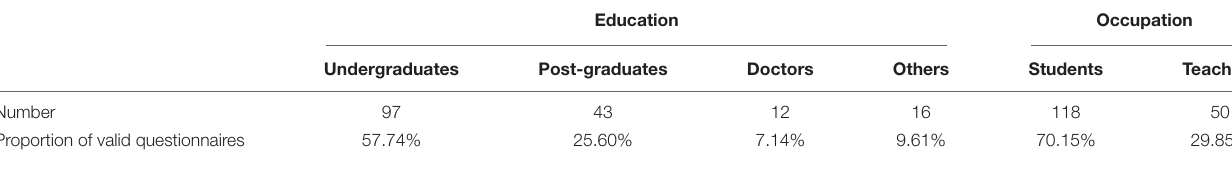
TABLE 7 | Educational backgrounds and occupations of the